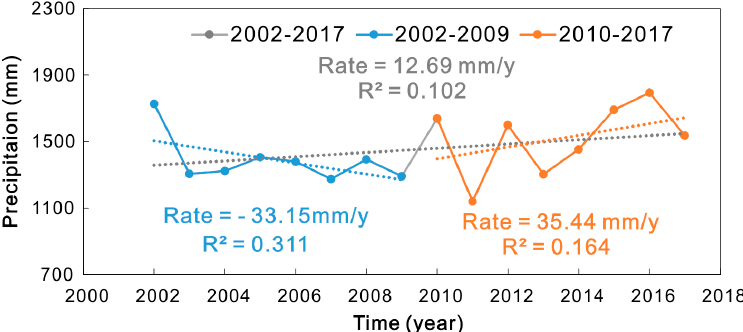
Figure 9. Annual precipitation derived by the Tropical Rainfall Measurement Mission (TRMM) data in the MLYB during 2002–2017, with precipitation change rates and determination coefficients (R 2 ) over three periods.